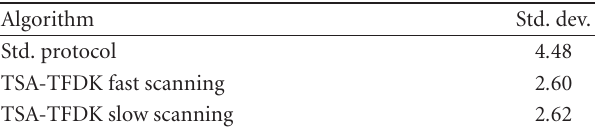
Table 2: Standard deviation of the values within the inserts for the reference protocol and the TSA approaches.